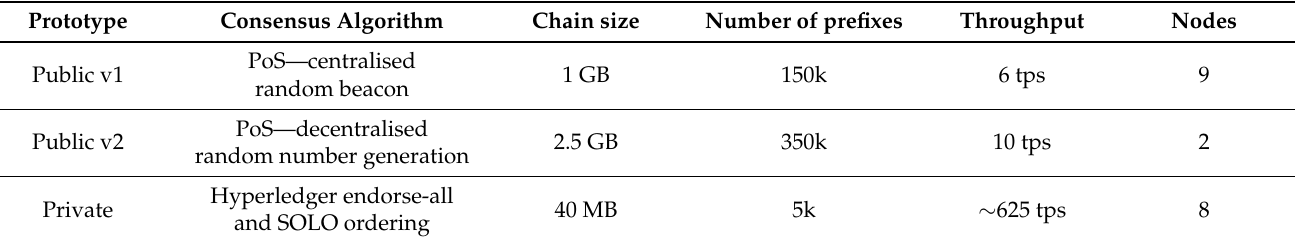
Table 2. Summary of the different blockchain prototypes and experiment results. tps stands for transactions per second.